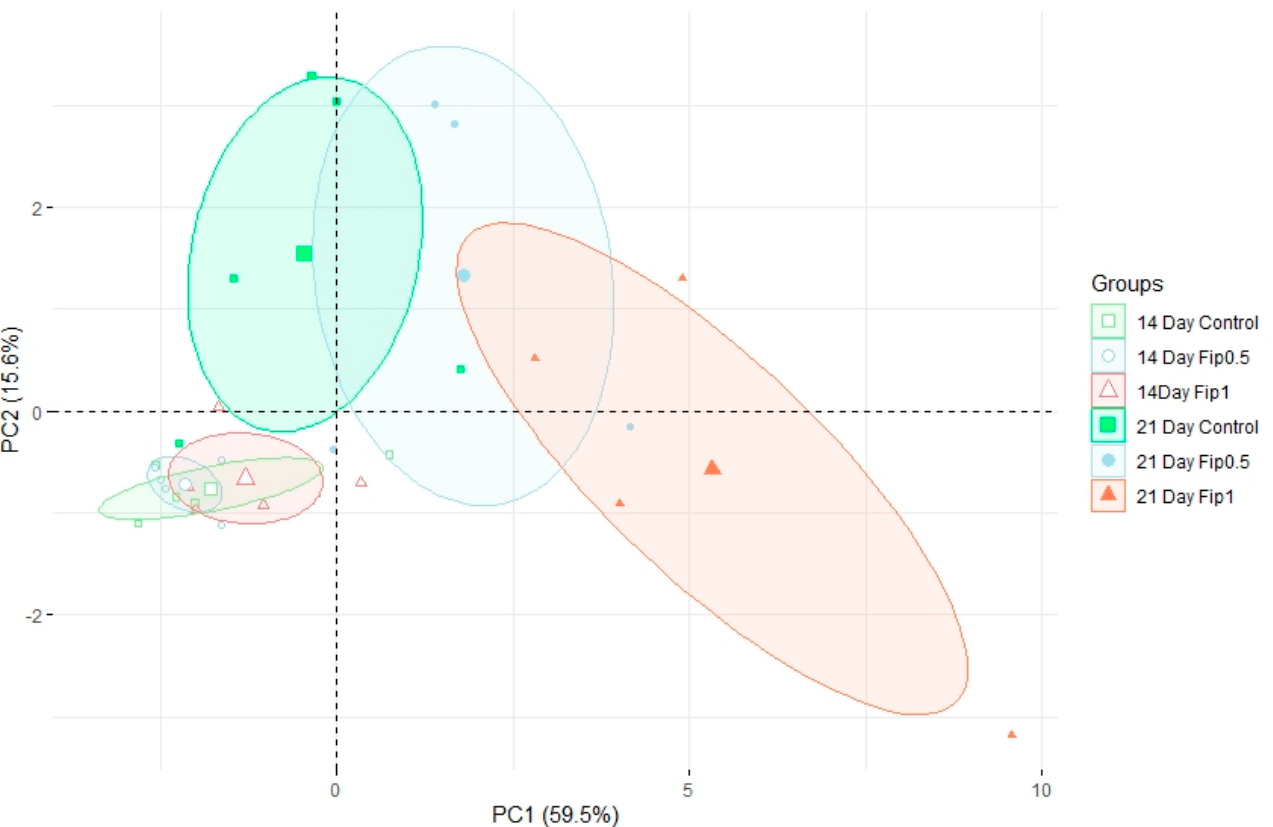
Figure 3. Normed PCA showing the volatolomic profiles in A. mellifera exposed or not to different fipronil concentrations. For each of the 6 conditions, 4 − 5 pools of 5 abdomens were analyzed. For each group, the large icon (specific to each group) represents the barycenter of the group. The ellipses are 95% confidence ellipses, which means that in 95% of cases, a point belonging to a group will be found inside the ellipse of that